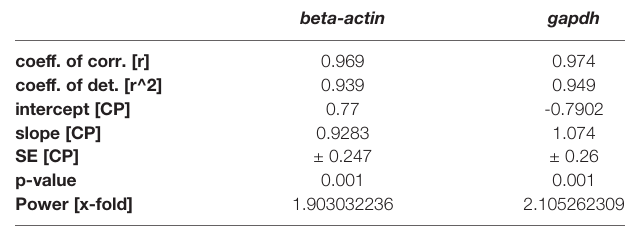
TABLE 1 | Bestkeeper analysis for stability of reference